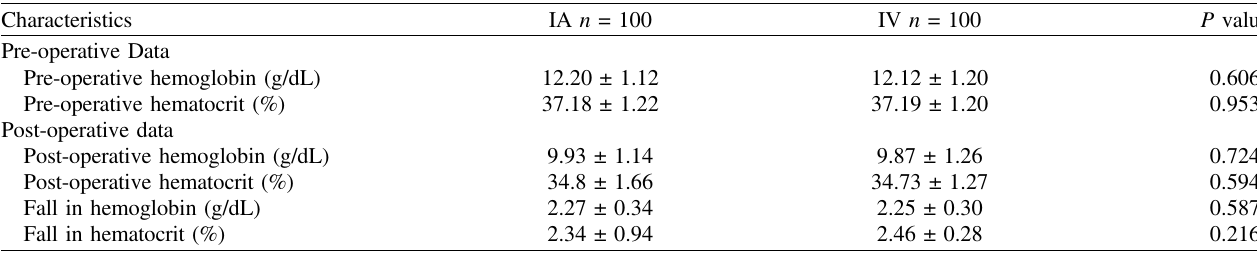
Independent sample t -test, observed difference was statistically insigni fi